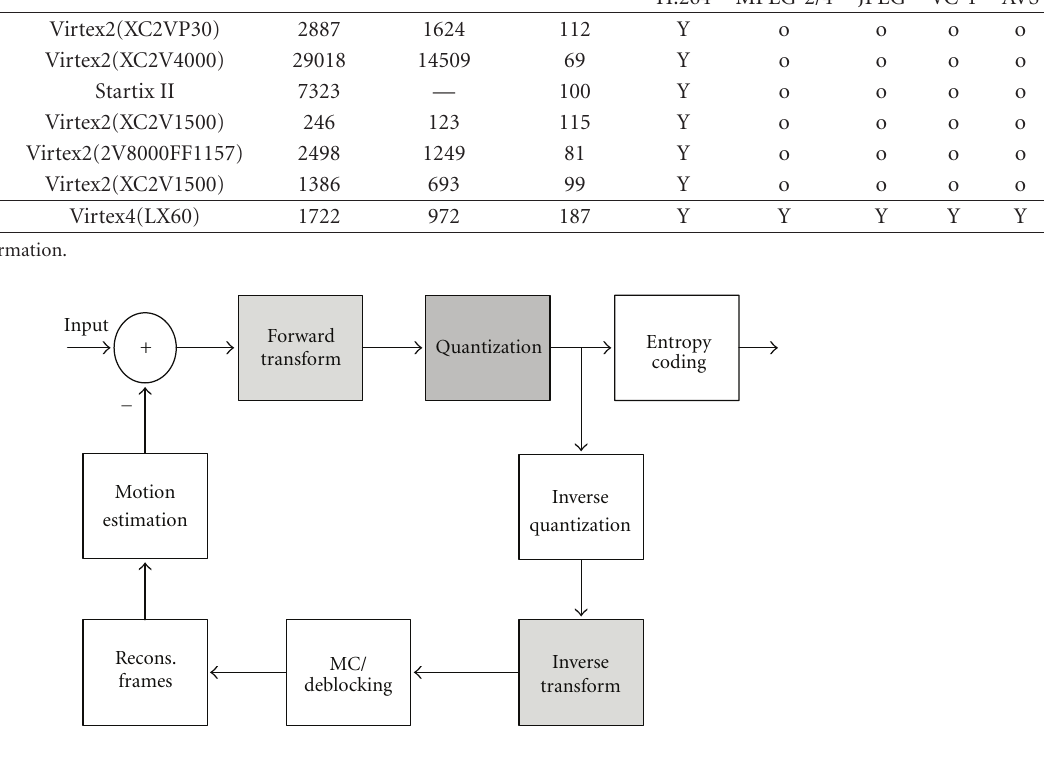
Table 4: Comparison with existing designs (transform and quantization). Arch.